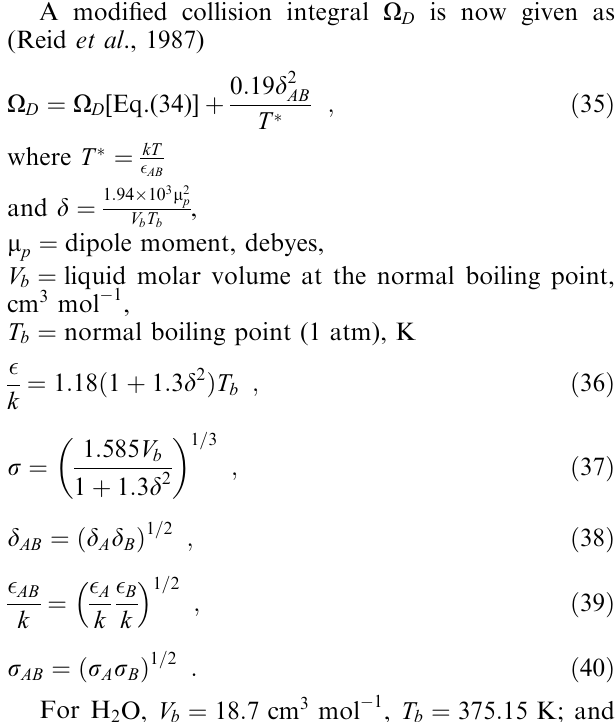
Fig. 6. D v (cid:133) (cid:113)